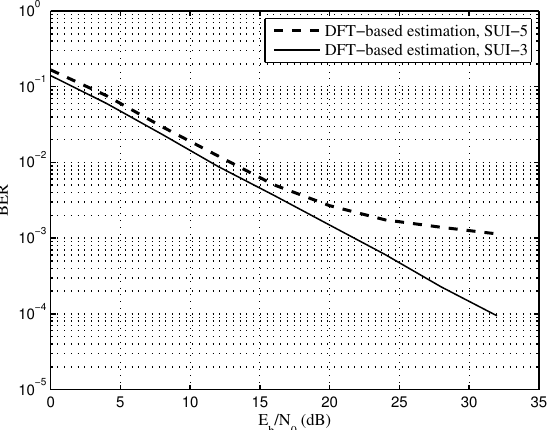
Figure 14. BER of the proposed DFT-based method, time synchronization error L e = 10 µ s.